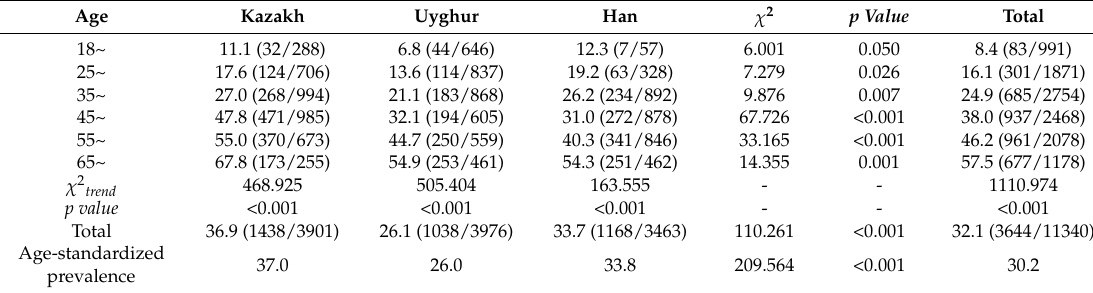
Table 3. Prevalence of hypertension by age and